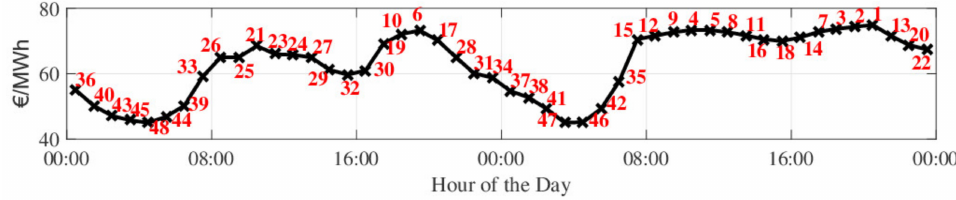
Figure 2. Electricity price profile for two days, with red labels of hourly prioritization.